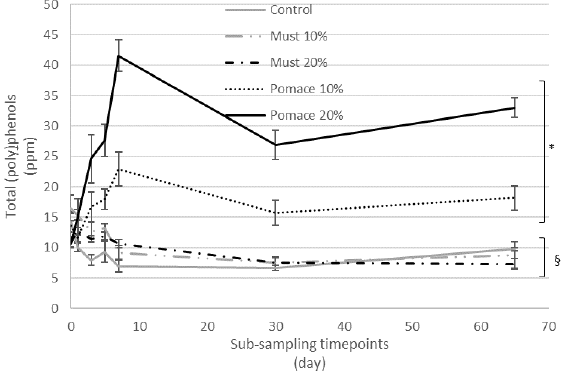
Figure 2. Kinetic of total (poly)phenols quantified by MS during the different timepoints from the beginning of fermentation to the final obtained beer (sub-samples collected at 0, 1, 3, 5, 7, 30 and 65 days). Results are expressed as ppm and are the mean of three separate analyses. * p < 0.05 indicates a significant increase in total (poly)phenols in the final beers, compared to the corresponding T0 value. § p < 0.05 indicates a significant decrease in total (poly)phenols in the final beers, compared to the corresponding T0 value.